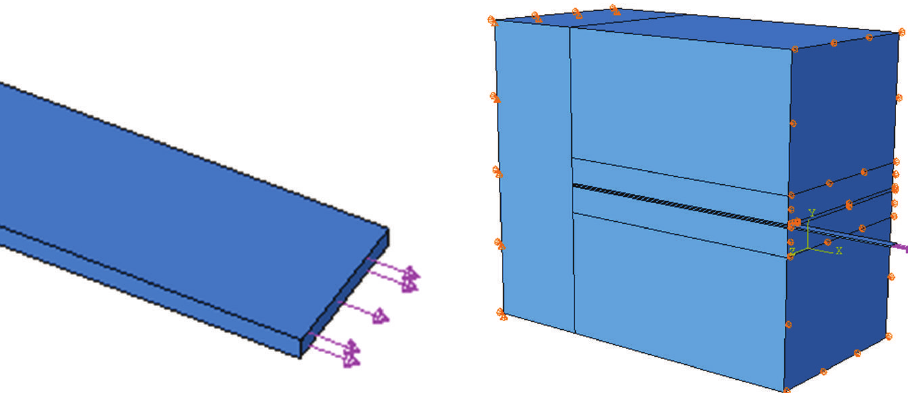
Figure 4: The loading and boundary condition of reinforced concrete system.